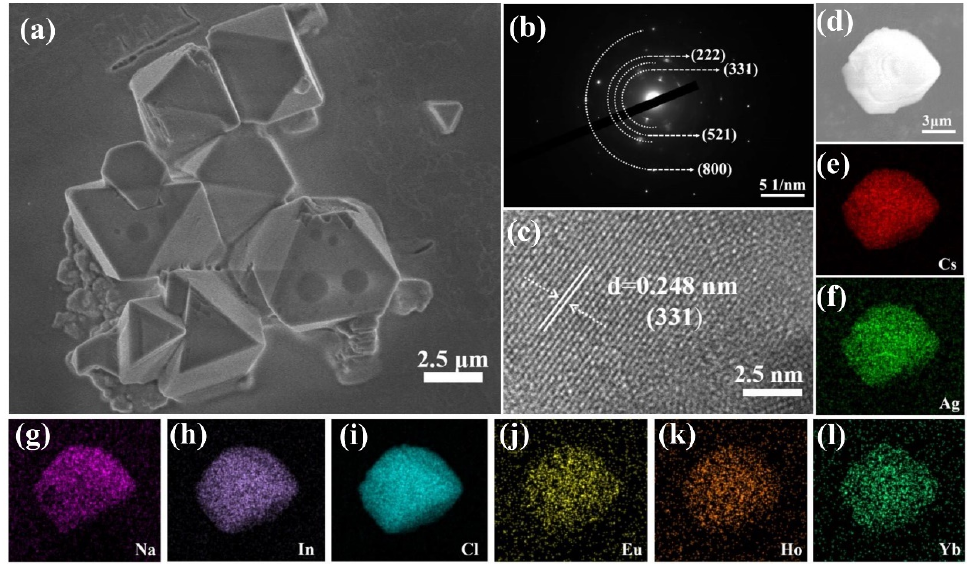
Figure 1. ( a ) SEM image, ( b ) SAED pattern, ( c ) HRTEM image, and ( d – l ) EDX elemental mappings (Cs, Ag, Na, In, Cl, Eu, Ho, and Yb) of Cs 2 Ag 0.3 Na 0.7 InCl 6 : Yb 3+ /Eu 3+ /Ho 3+ MCs. Powder XRD characterization is performed to determine the crystallinity and phase purity of the as-prepared Ln 3+ -doped/undoped Cs 2 Ag 0.3 Na 0.7 InCl 6 DPs. As presented in Figure 2, all samples exhibit obvious diffraction peaks, which correspond to the cube phases of Cs 2 Ag 0.3 Na 0.7 InCl 6 (JCPDS No. 74-0484), meaning the phase structure of the ma- trix can be retained after doping. It is worth noting that all of the diffraction peaks are sharp and without any additional peaks after doping, indicating their excellent crystallin- ity and high purity [19]. The split XRD peaks observed between 40° and 55° can be con- firmed as the overlapped two peaks corresponding to pure Cs 2 Ag 0.3 Na 0.7 InCl 6 host and the tridoped Cs 2 Ag 0.3 Na 0.7 InCl 6 MCs, meaning the presence of a mixed phase in the as-pre- pared tridoped Cs 2 Ag 0.3 Na 0.7 InCl 6 sample, which should be further optimized by precisely controlling the reaction parameters. Ln 3+ of Yb 3+ (0.86 Å), Eu 3+ (0.95 Å), and Ho 3+ (0.9 Å) can replace In 3+ (0.8 Å), Na + (1.02 Å) or Ag + (1.15 Å) theoretically. The replacement of Na +